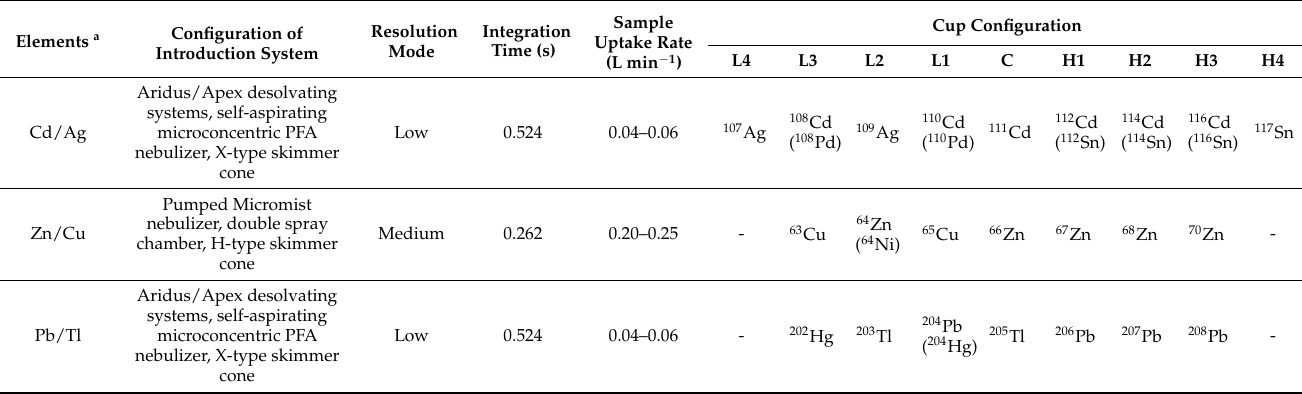
Table 1. MC-ICP-MS (multi-collector inductively coupled plasma mass spectrometry) operating parameters and measure- ment conditions for isotope ratio